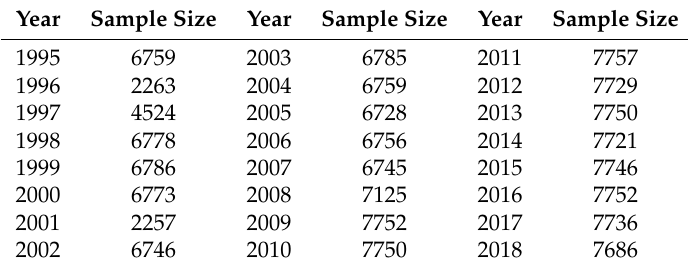
Table 1. Sample size for each year.